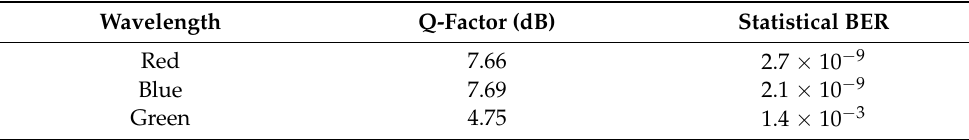
Figure 5. Transmitted and estimated data with the corresponding eye diagrams of the estimated data for: ( a , b ) the λ R , ( c , d ) λ B , and ( e , f ) λ G . Table 1. Q-factor and statistical BER.